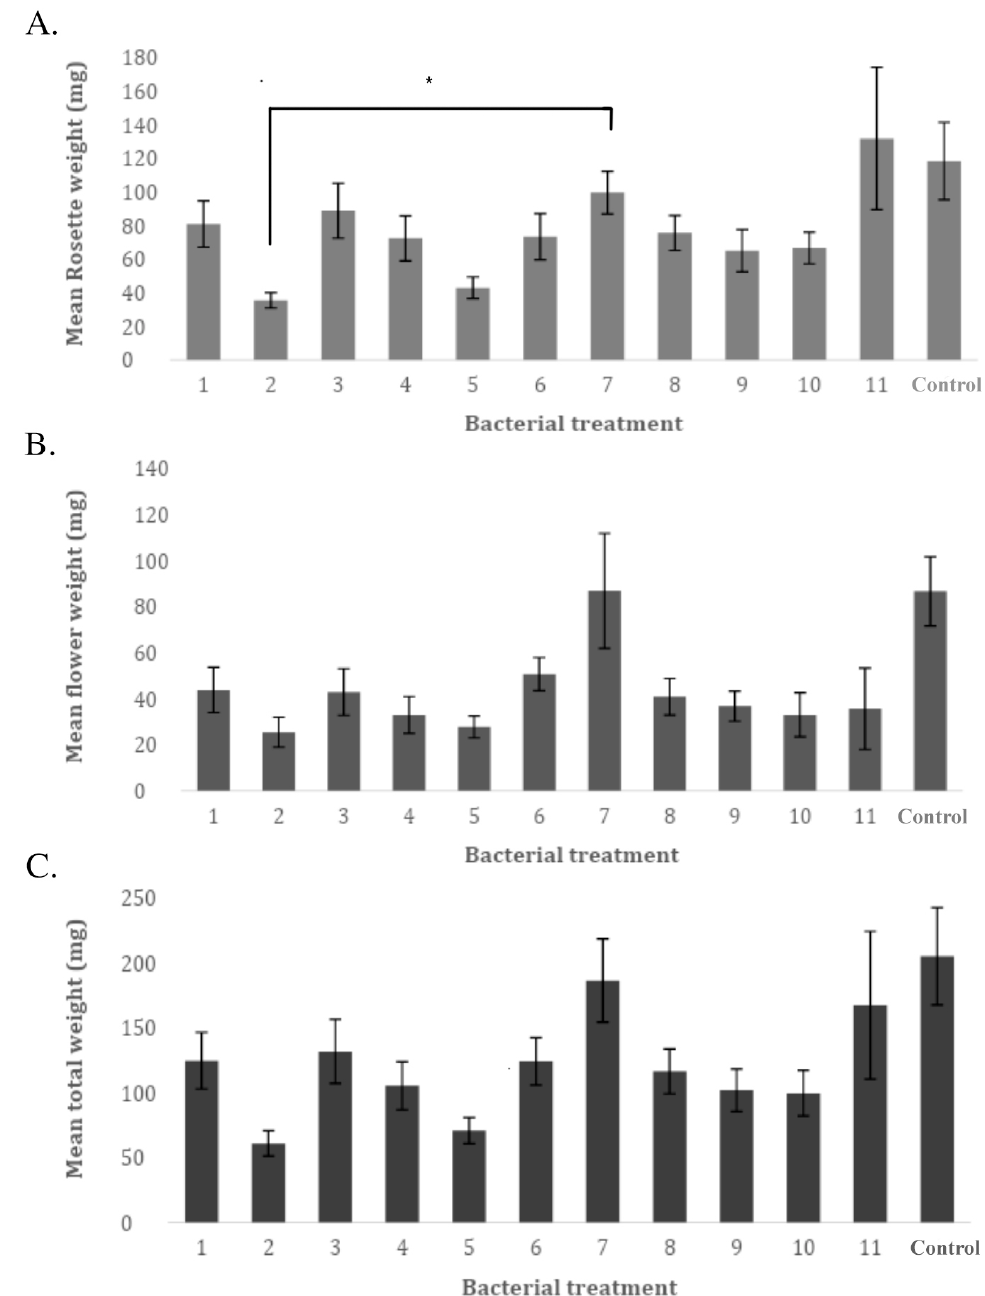
Figure 6. ( A ) Mean Rosette weight. ( B ) Mean flower weight. ( C ) Mean Total weight (root weight not included) of A. thaliana growing on heavy-metal-polluted soil pots. All A. thaliana seeds were inoculated with N. caerulescens seed isolates except for number 12 (no treatment: control). Weight was measured after 3 weeks of growth. A significant difference in biomass was analyzed by a one-way ANOVA Tukey HSD test and significance of p < 0.05 is indicated by an asterisk. All bacterial treatment numbers found on the x -axis correspond with Table